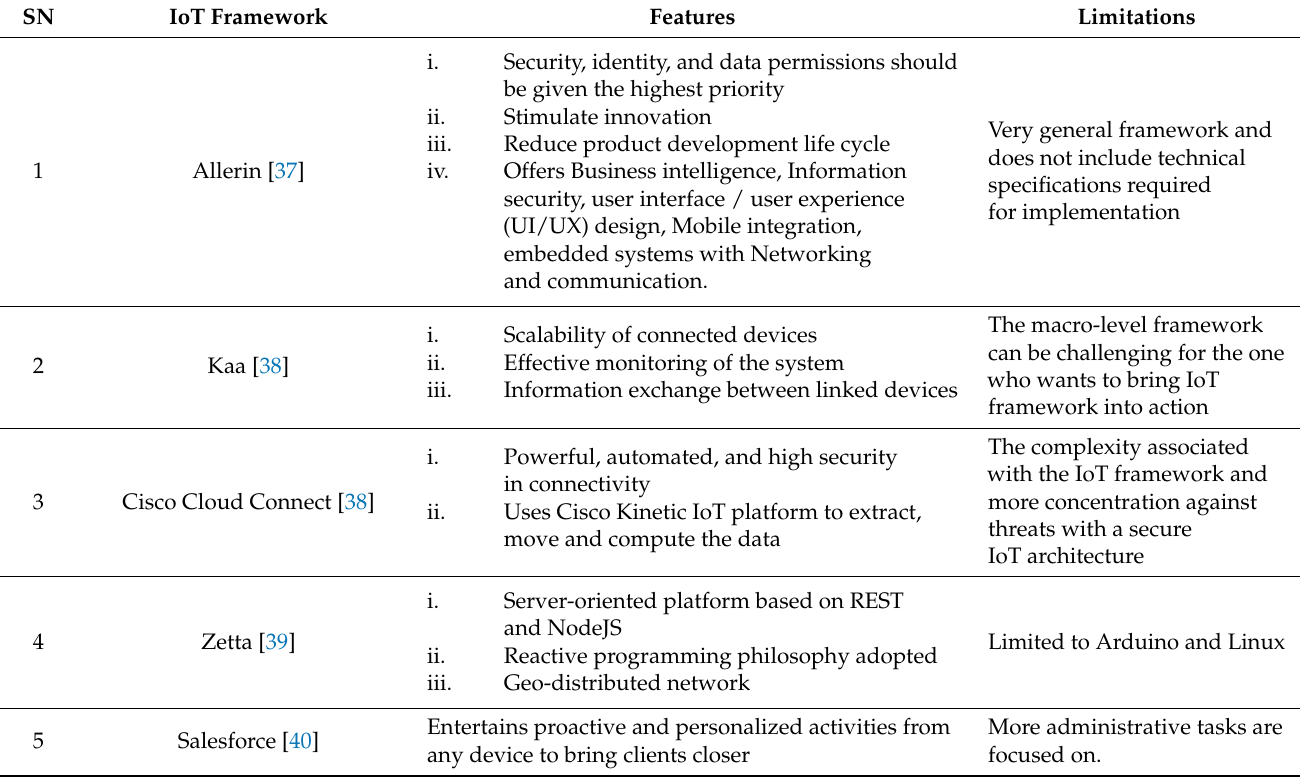
Table 2. Comparison of different IoT